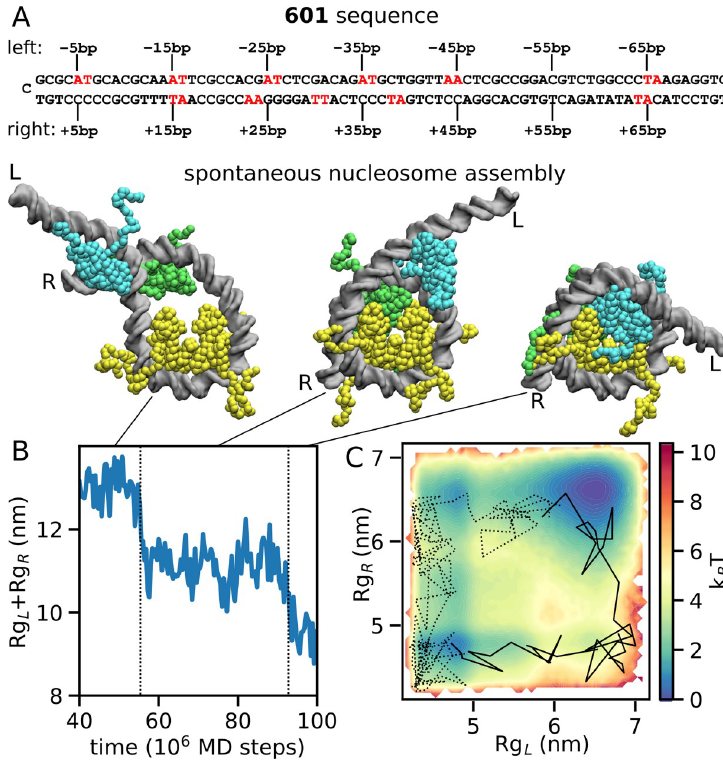
Fig 1. Simulation of nucleosome assembly on the 601-sequence. (A) The 601 DNA sequence. The left (0 to -73 bp) and right (0 to +73 bp) halves are shown on the first and second lines, relative to the dyad position at 0 bp (the left end), highlighting the locations of the A/T periodic motifs in red. (B) Representative nucleosome assembly simulation at 400 mM salt, showing the timeline of the sum of radii of gyration of the left and right halves of DNA (Rg L +Rg R ) during the formation of a complete nucleosome starting from a tetrasome. In the 3 snapshots corresponding to tetrasome (left), hexasome (center) and nucleosome (right), the DNA is shown in grey, the H3/H4 tetramer in yellow, the H2A/H2B dimer binding to the left side of 601 in cyan, and the H2A/H2B dimer binding to the right in green (throughout the paper, the same color code is used). The left and right DNA entry/exits are indicated by the letters L and R respectively. (C) The same trajectory as in panel B (at 400 mM, solid line) projected on the two dimensions Rg L and Rg R , together with one successful trajectory at 200 mM (dotted line). The trajectories are superimposed on the free energy landscape at 400 mM calculated by the Markov state model.